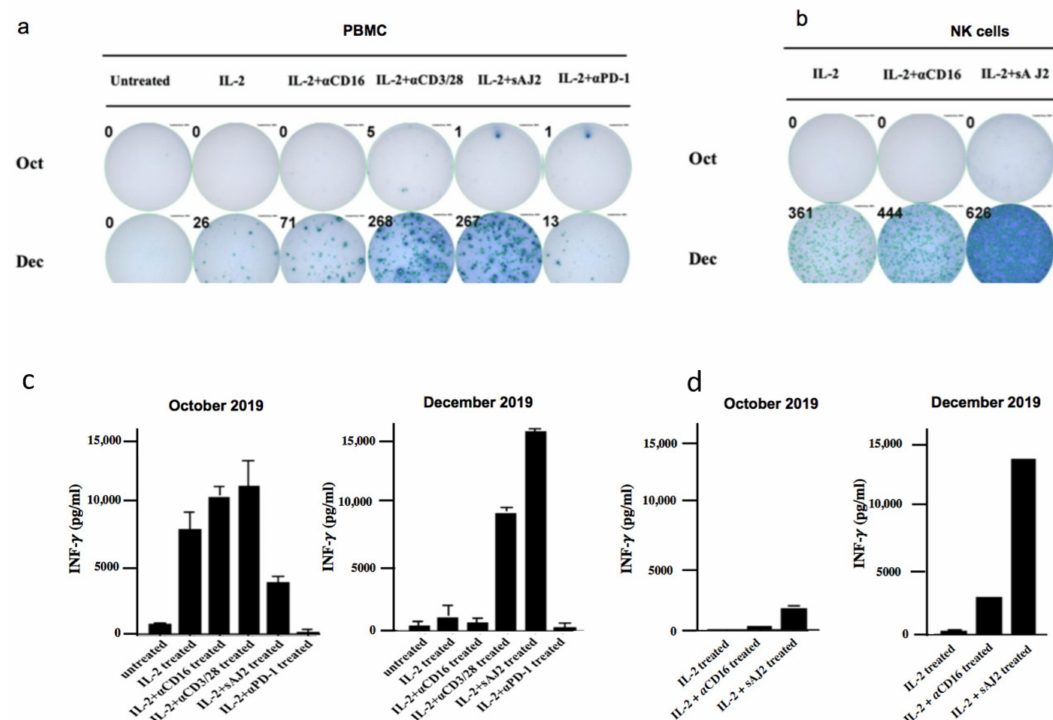
Figure 4. Significant improvement in IFN-g spots and secretion from both PBMCs and NK cells. PBMC and NK cells sorted from PBMCs were left untreated or treated with IL-2 (1000 U/mL), the combination of IL-2 and anti-CD16 mAb (3 µ g/mL), IL-2 and anti-CD3/28 antibody, IL-2 and sonicated probiotics (sAJ2) (bacteria: PBMC, 20:1) or anti-PD-1 antibody (10 ng/mL) for 18 h. ELISPOT ( a , b ) was conducted to determine the numbers of cells demonstrating the IFN-g spots represented by the number and size of IFN-g spots. Supernatants were also collected after 18 h of the treatment and ELISA ( c , d ) was performed to measure the concentration of IFN-g secreted within the